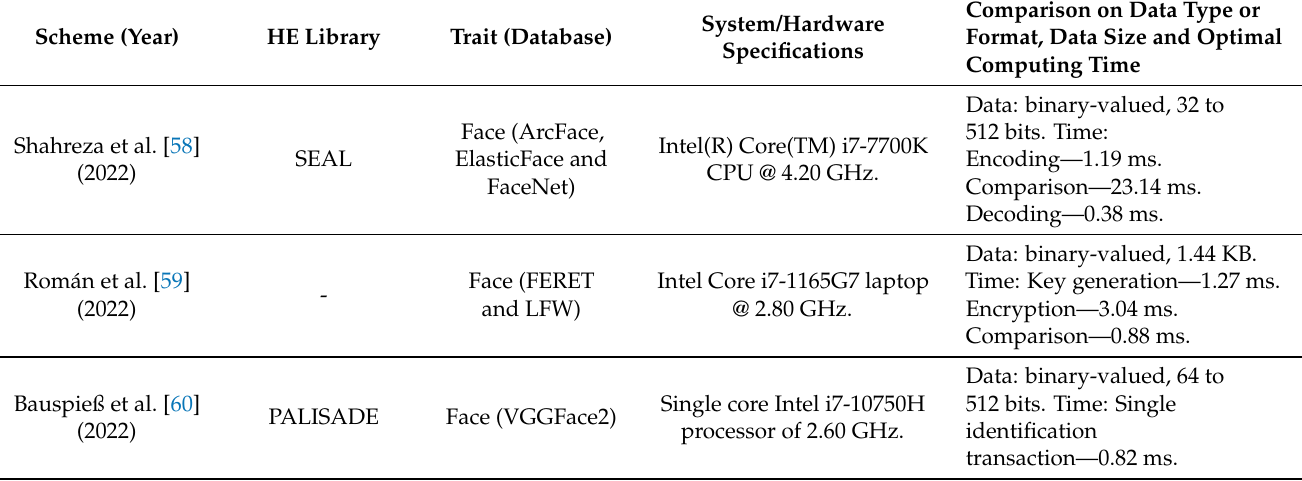
Table 2. Comparison of HE-based approaches to face security in terms of computational